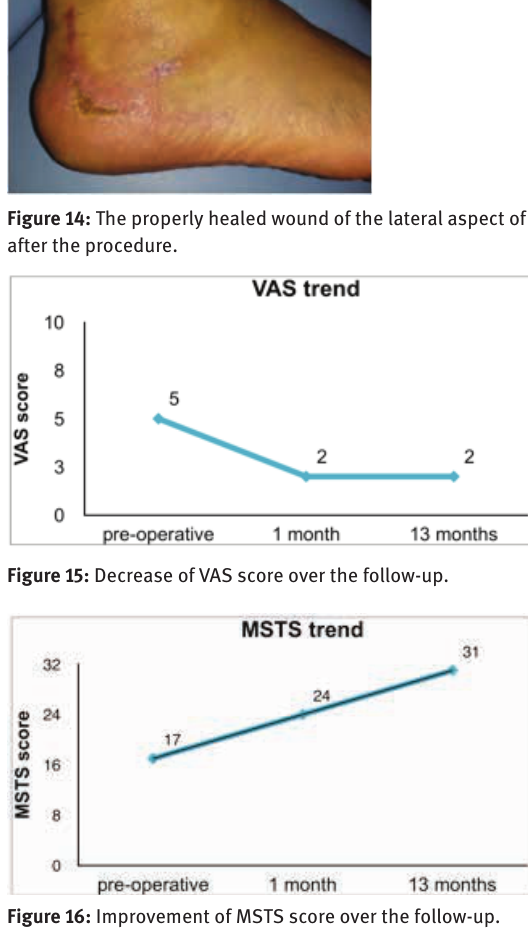
Figure 16: Improvement of MSTS score over the follow-up.